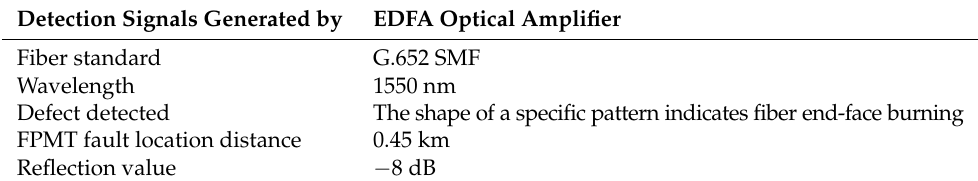
Table 8. The parameters and practical results detected at event 4.